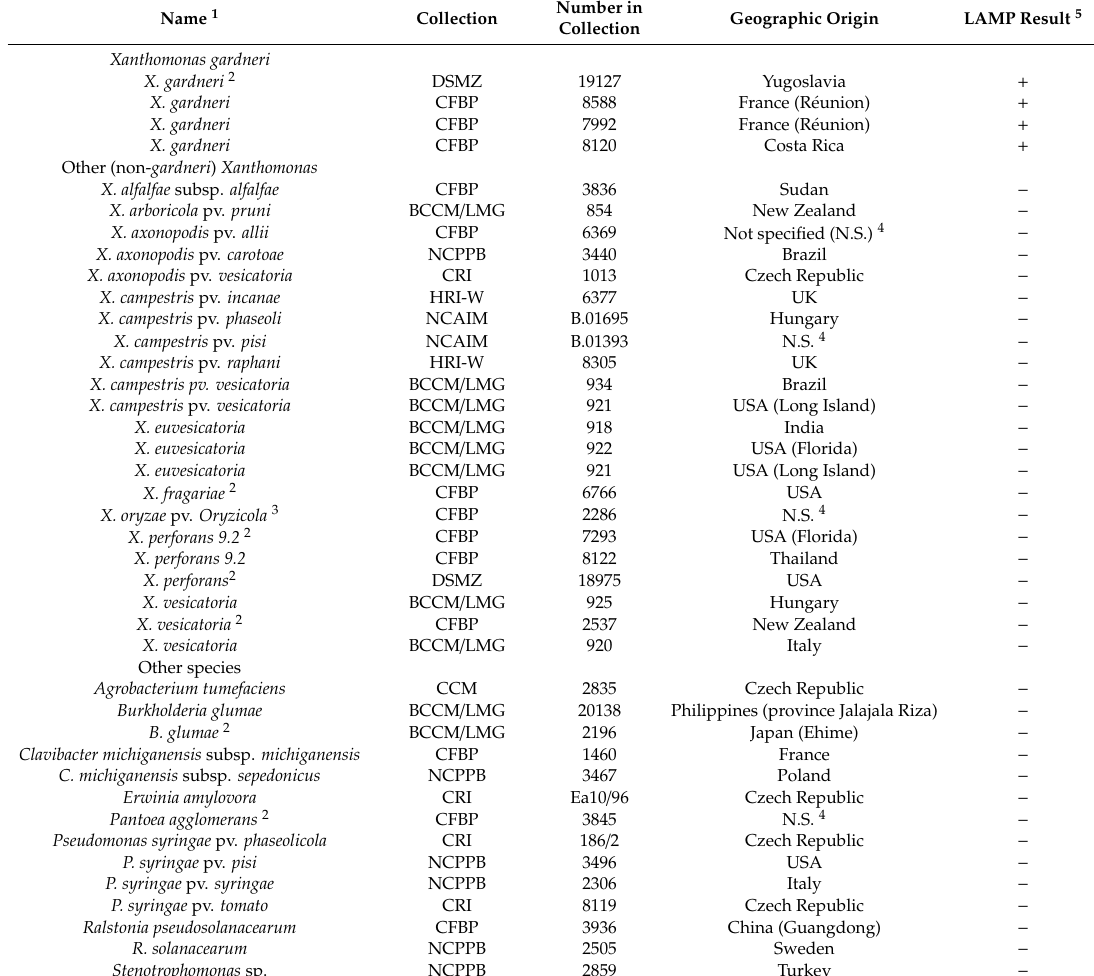
Table 1. 1 Bacteria listed in collection; 2 Type; 3 Pathotype; 4 not specified (N.S.) by